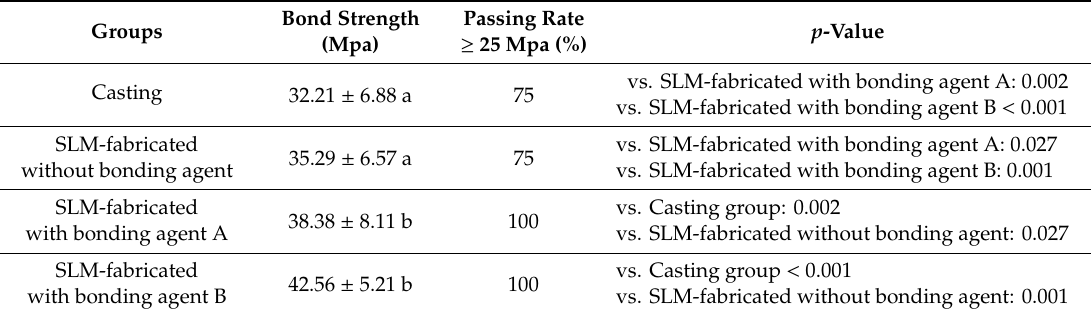
Table 4. Metal–ceramic bond strength (mean ± standard deviation) and passing rate ( ≥ 25 MPa). Groups